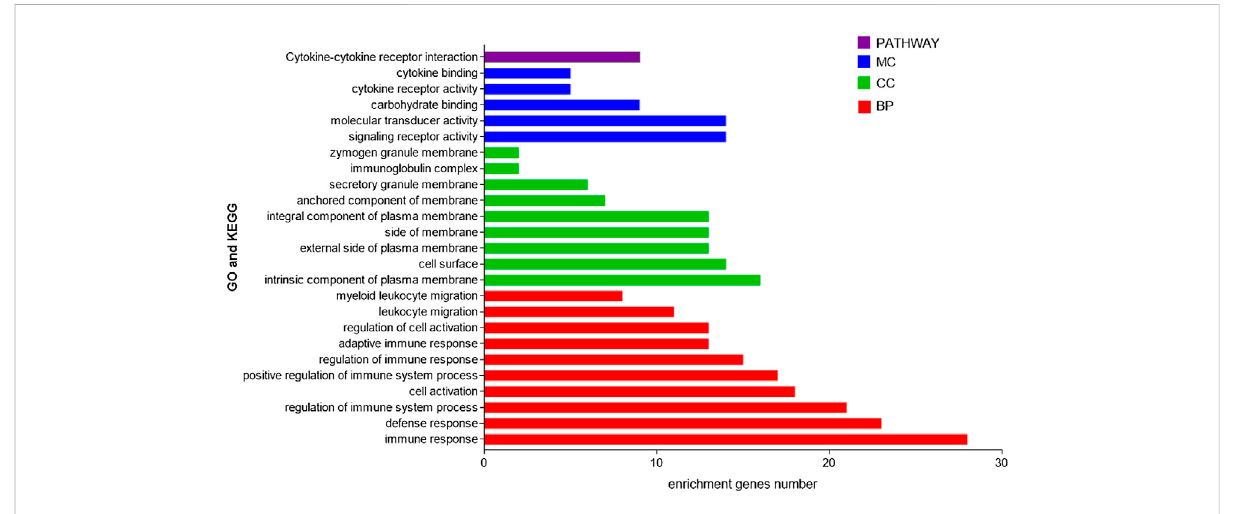
FIGURE 4 GO and KEGG enrichment analyses of DEGs in two